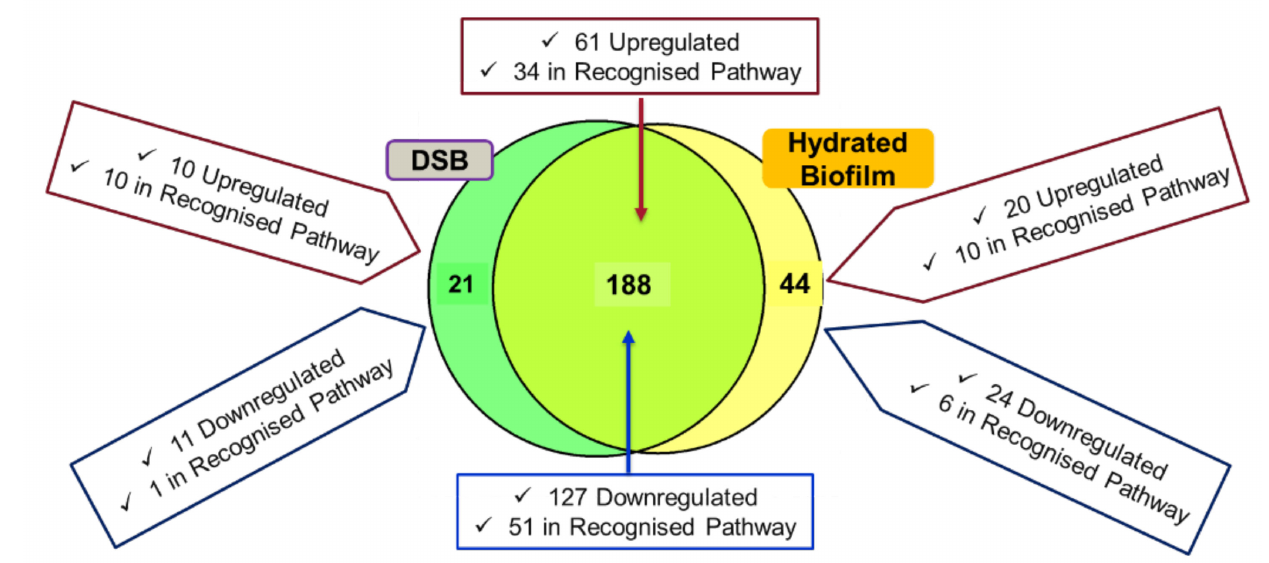
Figure 1. This Venn diagram represents identified proteins dysregulated >2-fold, p < 0.05 in com- parison with 24 h planktonic culture. It shows the dispersion of common proteins (188) between hydrated and DSB as well as uniquely identified proteins based on abundance ratios in the hydrated biofilm (44) and DSB (21). Pathway analysis was performed using